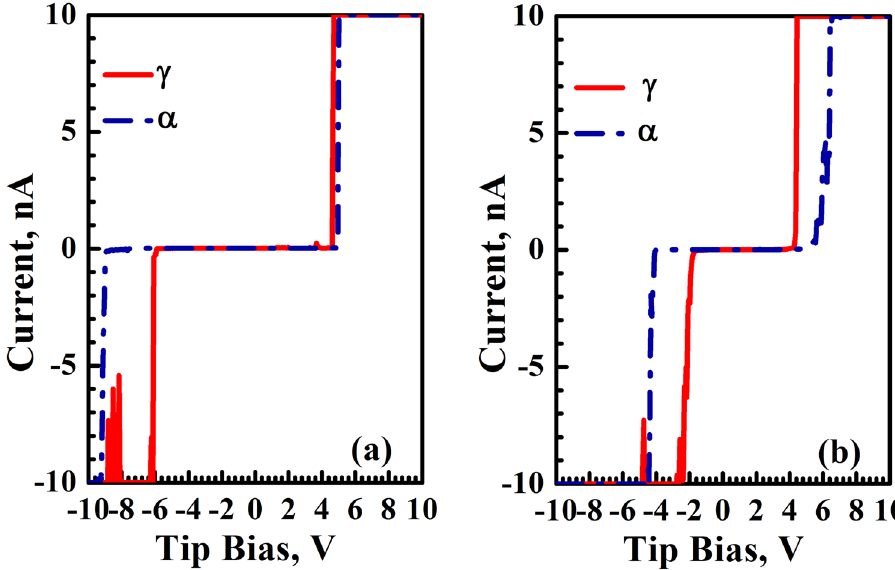
Figure 2. Typical I–V curves obtained from the passive films on the ferrite and austenite phases formed on duplex stainless steel ( a ) before hydrogen charging and ( b ) after hydrogen charging.